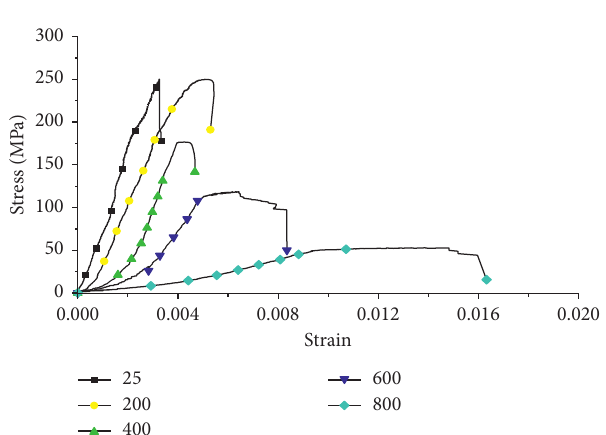
Figure 6: Stress-strain curve of uniaxial compression test (natural cooling).